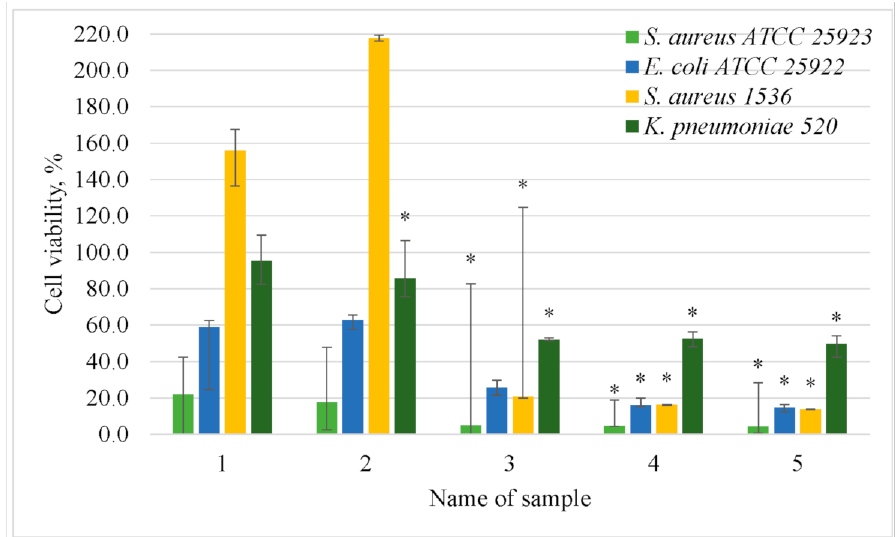
Figure 6. Value of adhered cells after subculturing with supernatant (crystal violet). The yeast extracts were obtained from samples of yeast S. cerevisiae 71B, cultured in 20% glucose solution with the addition of: (1) sterile dH 2 O, (2) 0.5 mM AgNO 3 , (3) 1.0 mM AgNO 3 , (4) 1.5 mM AgNO 3 and (5) 2.0 mM AgNO 3 . * p <